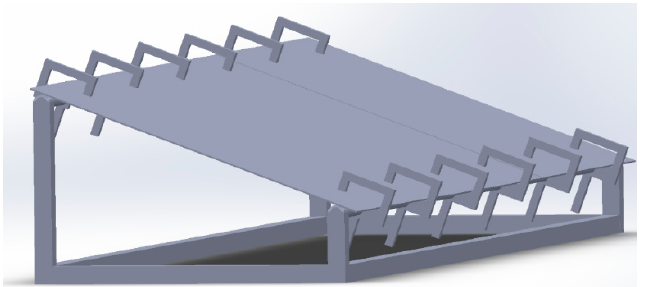
Figure 13. 3D mirror support structure view. 3D model, in which the concept shown in Figure 12 is applied.